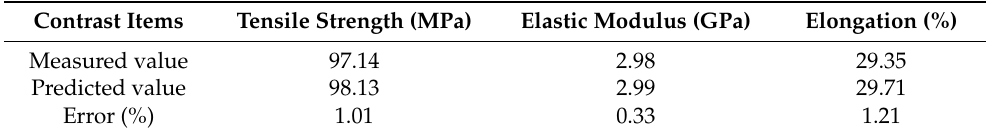
Figure 8. Optimal results. Table 6. Validation testing